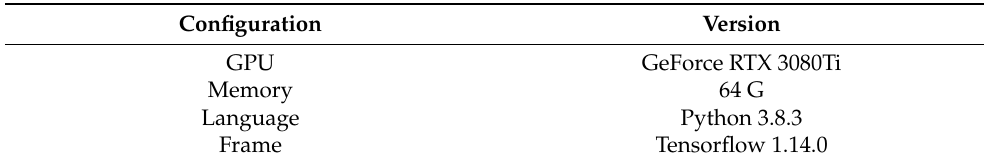
Table 7. Hardware and software configurations of the